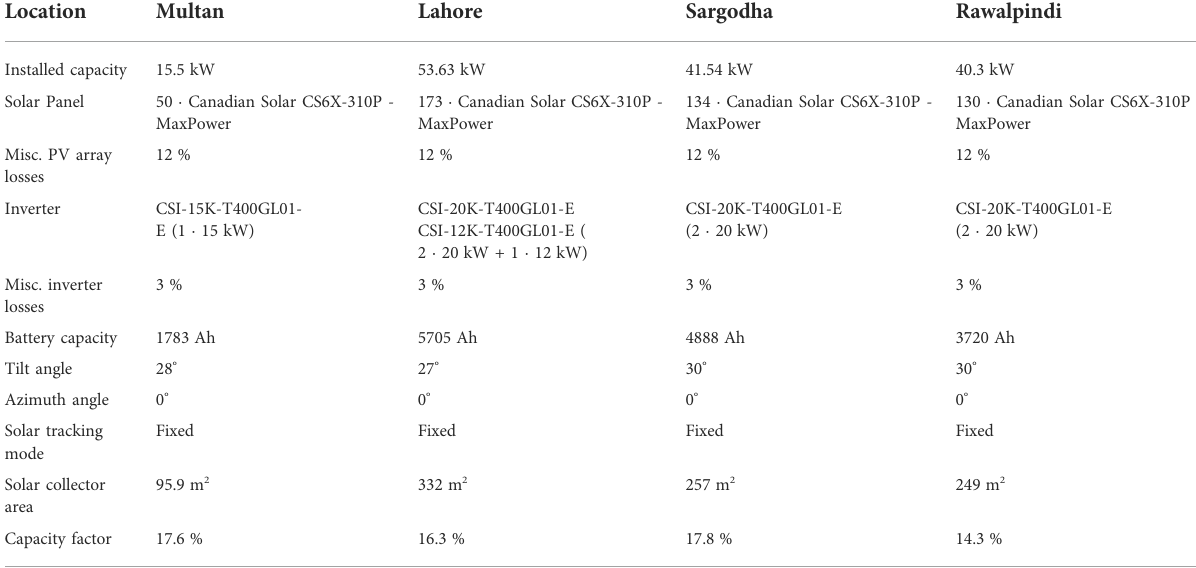
TABLE 6 Technical input variables used in the PV system